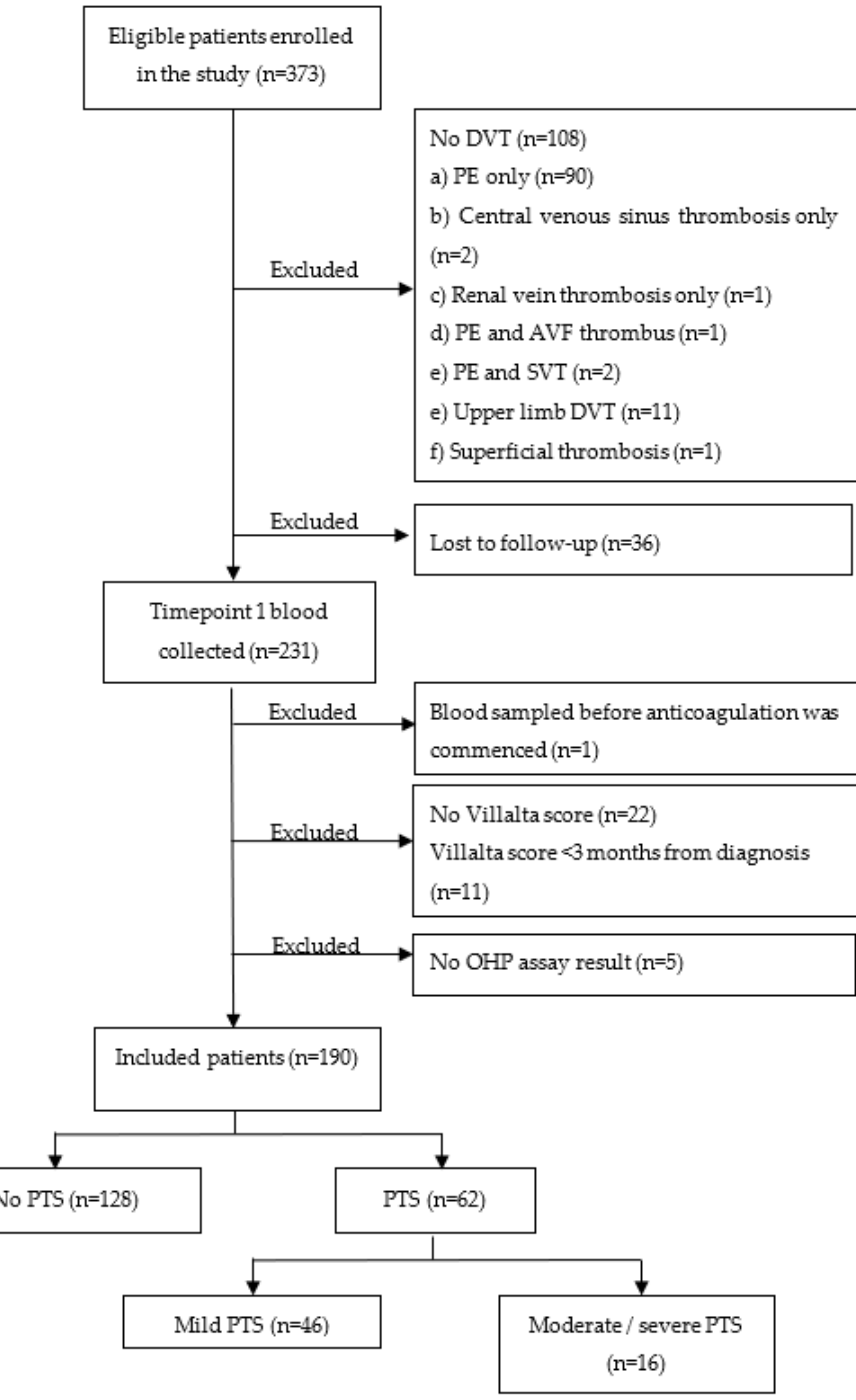
Figure 2. Consort diagram illustrating the inclusion and exclusion of study participants.